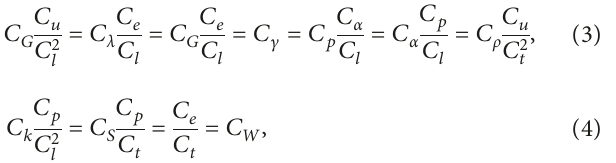
(mining face 5-1 at a mining length of 2100mm). f